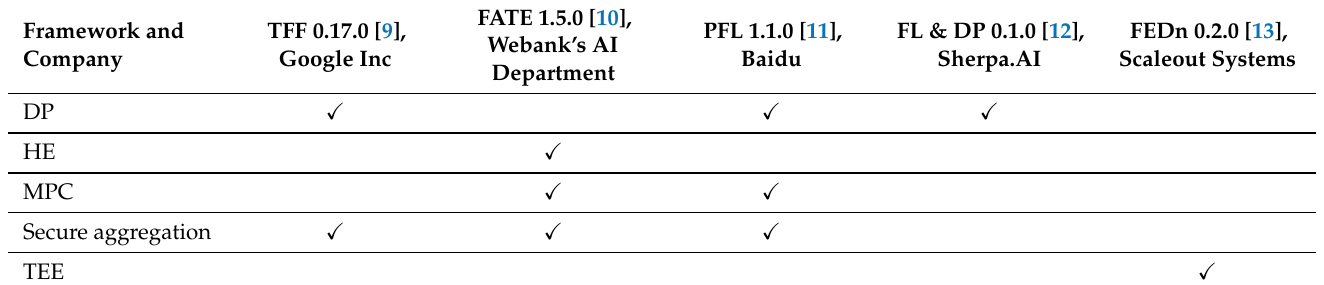
Table 2. Types of privacy mechanisms implemented in open-source FL systems. Framework and